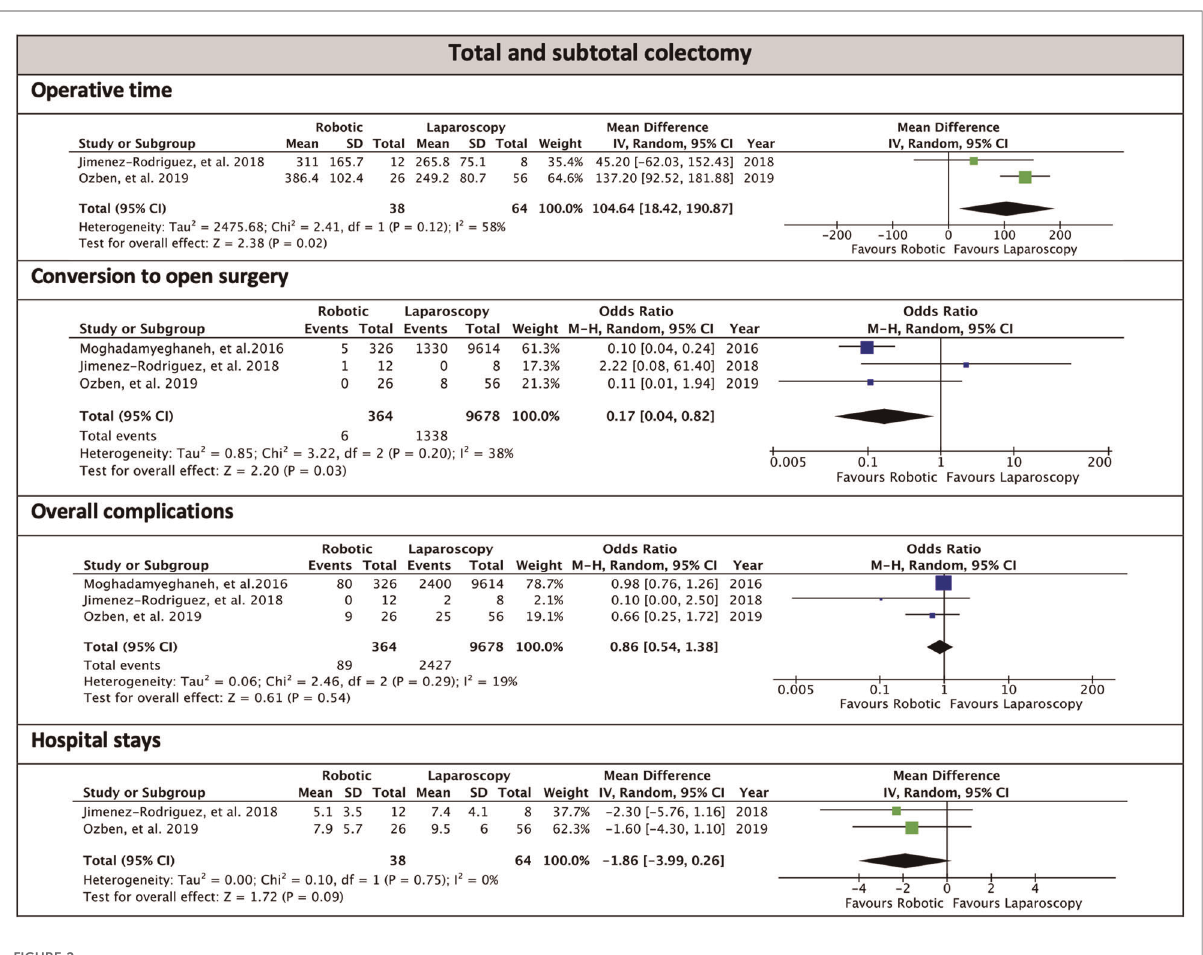
FIGURE 2 Subgroup of total and subtotal colectomy, forest plots of the overall